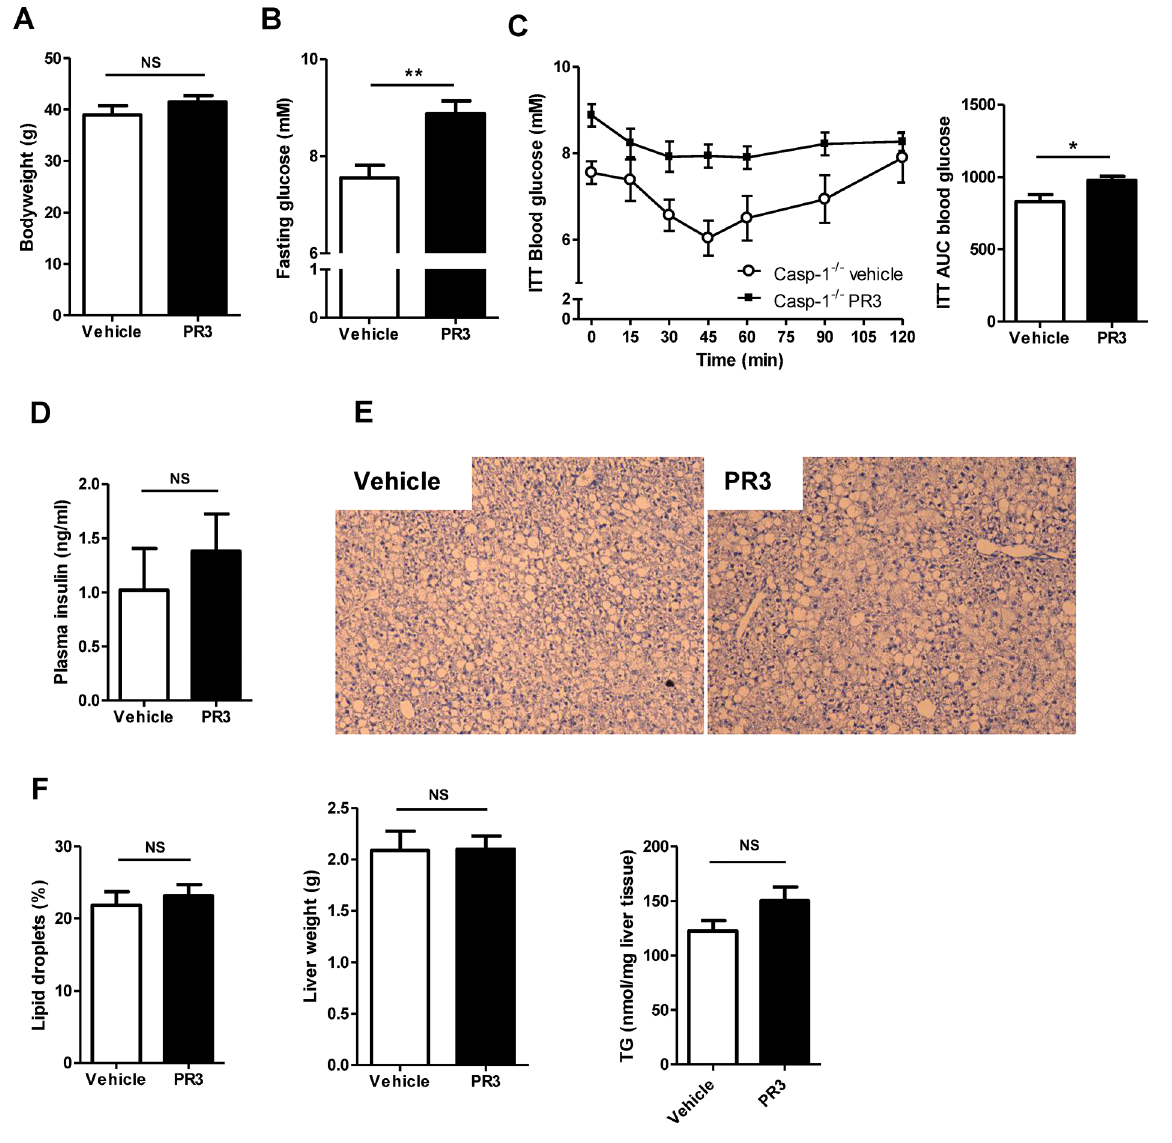
Figure 5. Injected proteinase 3 induces insulin resistance in caspase-1-deficient mice during the last 10 d of a high-fat diet. (A) Body- weight of caspase-1 –/– mice treated with vehicle ( n = 10) or proteinase 3 ( n = 10) during last 10 d of a high-fat diet. (B) Fasting glucose levels at baseline. (C) Glucose levels during insulin tolerance test and ITT AUC values. (D) Plasma insulin levels. (E) HE staining of liver sec- tions. (F) Percentage of lipid droplets in HE-stained liver sections, liver weights and liver triglycerides. ITT, insulin tolerance test; PR3, proteinase 3; TG, triglycerides; *significant difference p ≤ 0.05; **significant difference p ≤